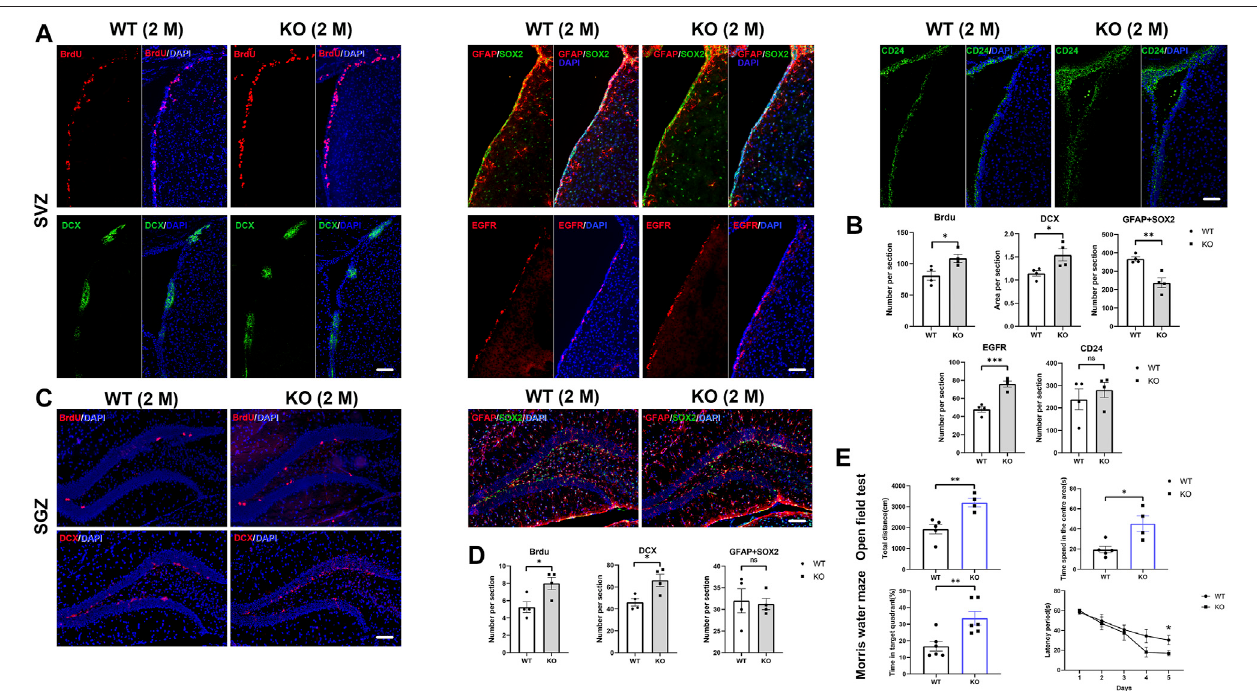
FIGURE 4 | Loss of Ttyh1 leads to enhanced neurogenesis in adult mice. (A,B) Immunolabeling ofcell-type-speci fi cmarkers and quanti fi cation of immunopositive cellsintheadultSVZ.TheBrdUretainingcells,Sox2 + GFAP + NSCs,EGFR + TAPs,DCX + neuroblastsandCD24ependymalcellswerecompared (A) andquanti fi ed (B) in SVZ between control and Ttyh1 KO mice at 2-months old (2 M). (C,D) Immunolabeling of cell-type-speci fi c markers and quanti fi cation of immunopositive cells in the adultSGZ.TheBrdUretainingcells,Sox2 + GFAP + NSCs,andDCX + neuroblastswerecompared (C) andquanti fi ed (D) inSGZbetweencontrolandTtyh1KOmice at 2 M. (E) Open fi eld and Morris water maze tests between control and Ttyh1 knockout mice. Scale bar (cid:2) 100 μ m in A, C. n ≥ 4 for all experiments. Data are expressed as mean ± SEM. Statistical signi fi cance was calculated using an unpaired, two-tailed Student ’ s t -test. ( ppp ) p < 0.001, ( pp ) p < 0.01, ( p ) p < 0.05.